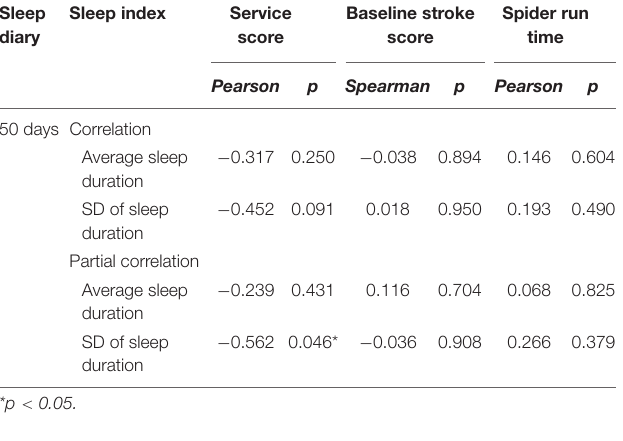
TABLE 1 | Summary of participants’ characteristics, sleep duration and athletic performance test score. No.